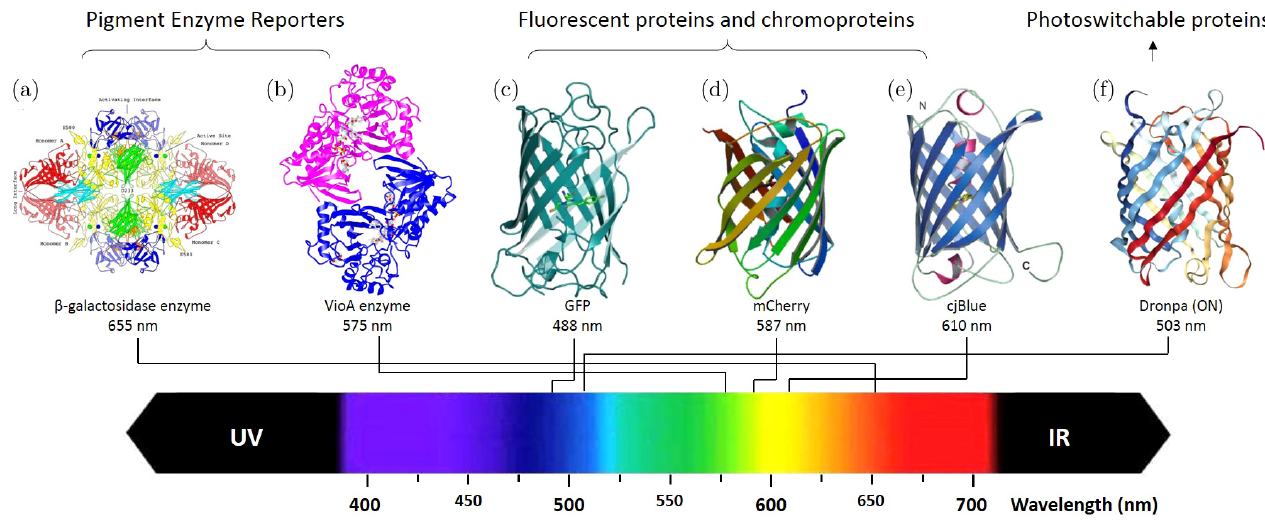
Fig. 1. Crystal structure and absorption maxima of the representative genetic reporters used in PAI. (a) The tetrameric structure of (cid:3) -galactosidase. 43 (b) Crystal structure of VioA from C. violaceum. 44 (c) Crystal structure of Green °uorescent protein (GFP). 45 (d) Crystal structure of mCherry. 46 (e) The monomeric cjBlue subunit. 47 (f) Bright-state structure of the reversibly switchable °uorescent protein Dronpa.